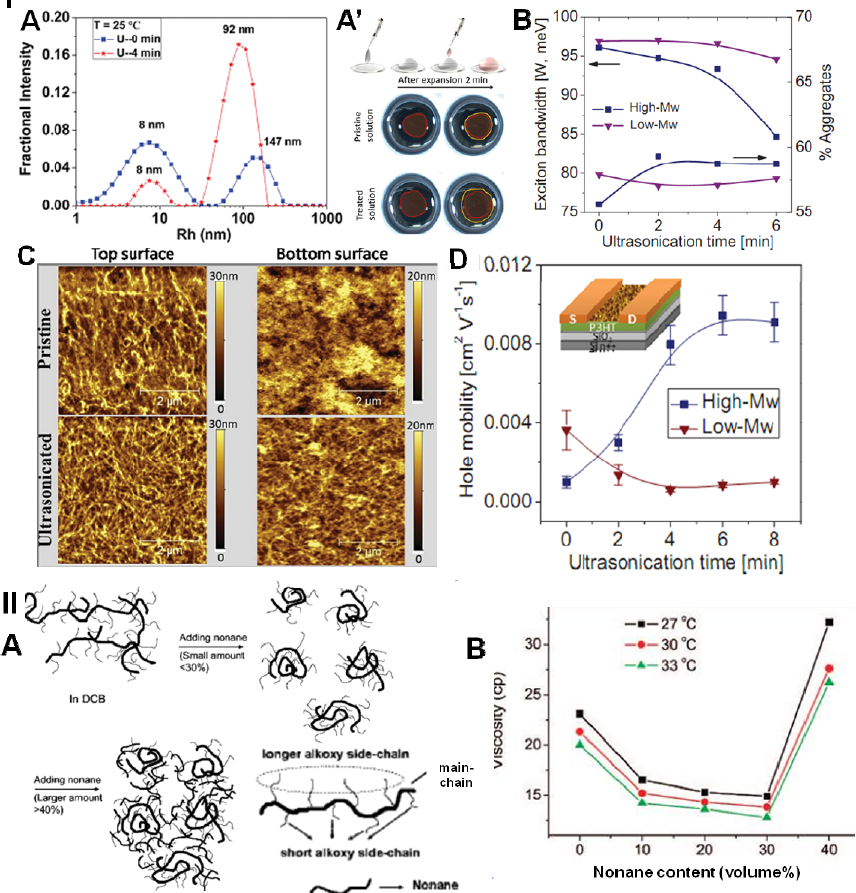
Figure 18. ( I ) The ultrasonic control of solution state and morphology for P3HT: ( A ) the DLS results of P3HT (87 k) solution in p -xylene without and after treatment, (Reprinted with permission from [146]. Copyright 2010 American Chemical Society); ( A’ ) the visible diffusion of solute diffusion into solvent for P3HT (low-MW, 35 k) without and after and 35 k for low- M ) treatment; ( B ) the aggregation order of P3HT (68 k for high- M w w solution with different treatment time; ( C ) the AFM images for high-Mw P3HT films cast from solution without and after treatment; ( D ) the device performance variation with the treatment time (Adapted with permission from [147]. Copyright 2013 Wiley-VCH Verlag); ( II ) The schematic illustration of the role of nonane played in the conformations and aggregation of MEH-PPV chains in DCB solution in ( A ) and the viscosity variation with adding content of nonane, (Reprinted with permission from [148]. Copyright 2008 American Chemical Society); and ( III ) The DLS results of PQT12 solutions in different solvents and the TEM images of corresponding films (20 °C, 0.1 mg/mL). (Adapted with permission from [143]. Copyright 2013 The Royal Society of